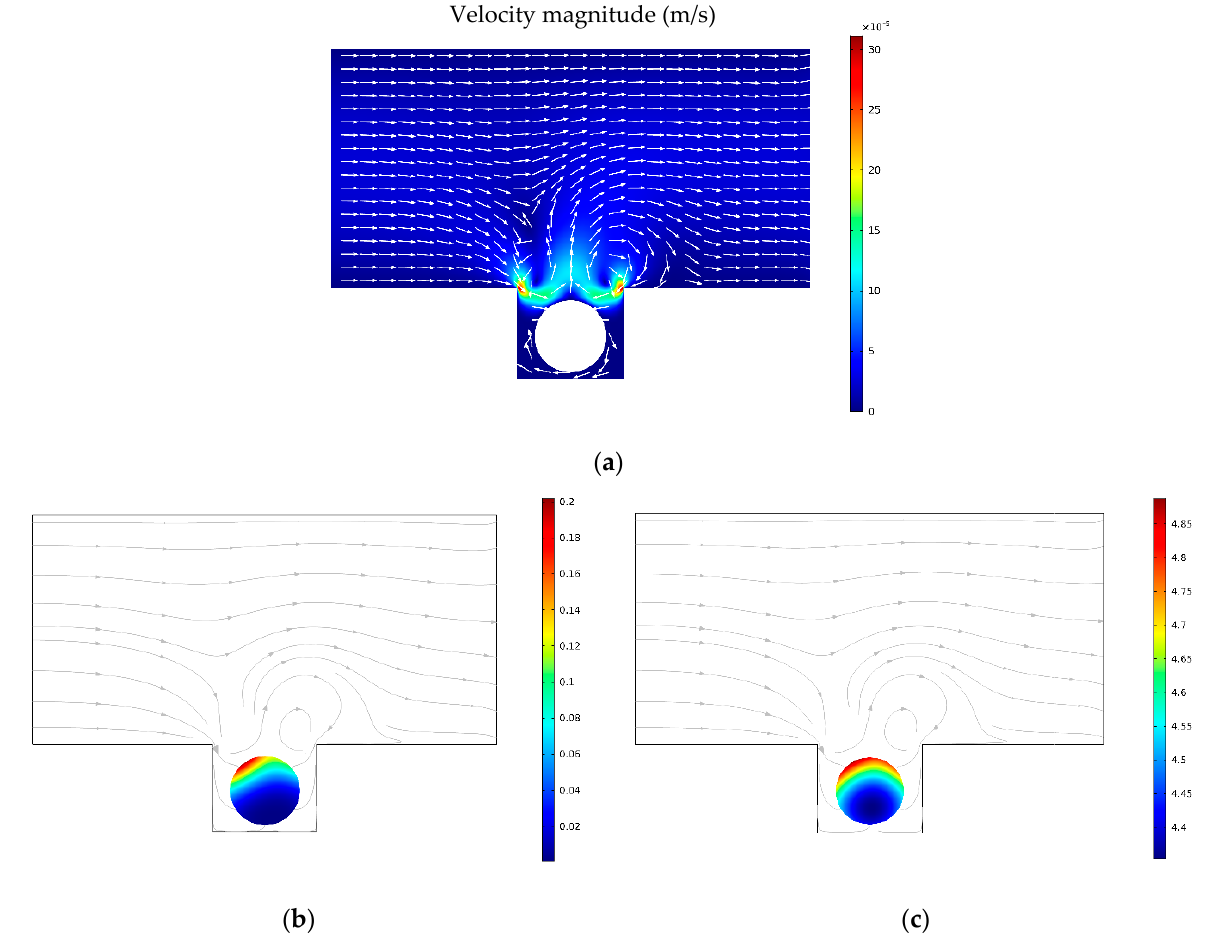
Figure 6. ( a ) Streamlines in the presence of the acoustic field. Near the microwell, the flow is mostly affected and forms a pattern similar to a vortex. This also leads to convection enhancement inside the well and around the spheroid. ( b , c ) Oxygen and glucose distribution and their fluxes, respectively, when the acoustic field is present. Acoustic field improved the proliferation zone significantly inside the spheroid.